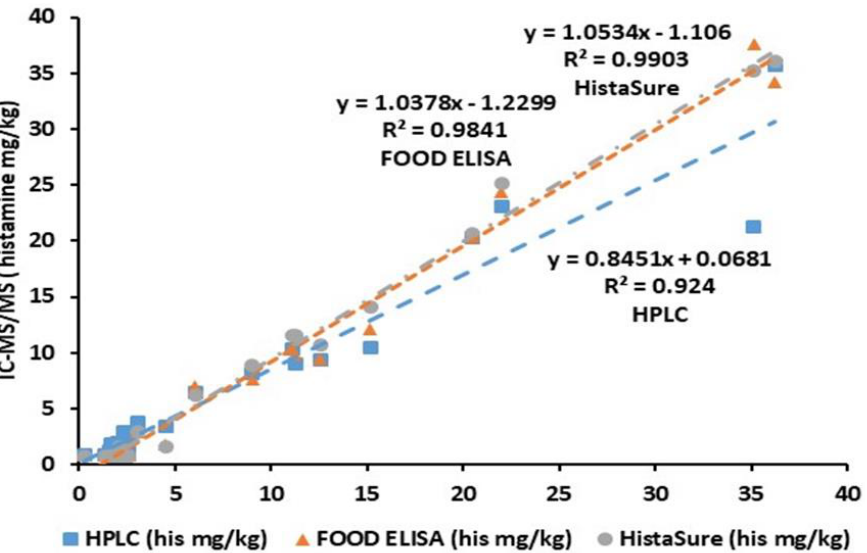
Figure 1. Correlation results of three quantitative methods against IC-MS/MS in determining histamine in various fish products.